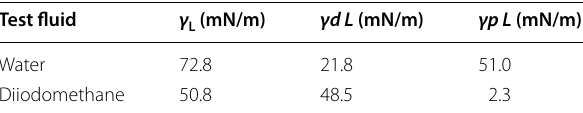
Table 1 Surface energy and their parameters of the test liquids [18]